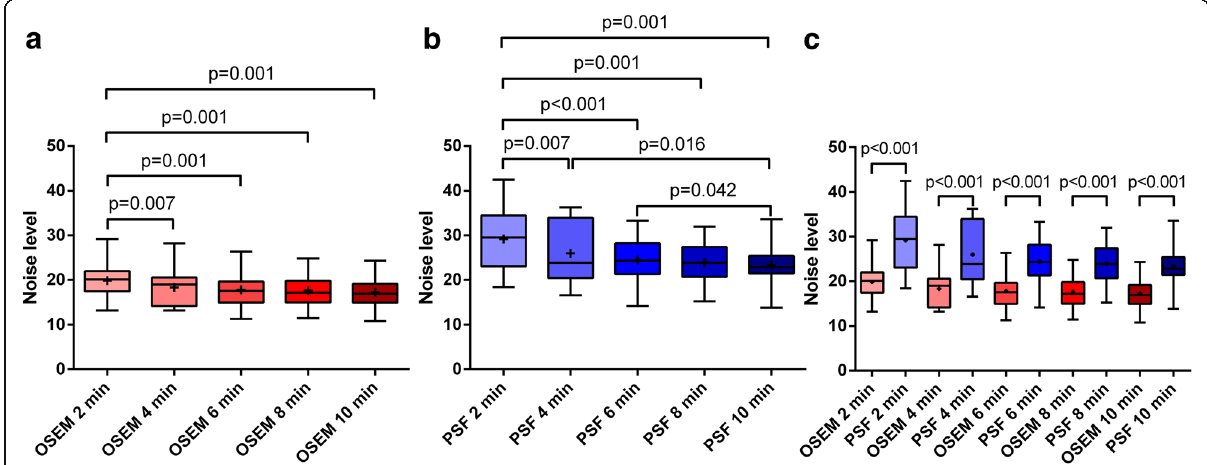
Fig. 1 Noise level measured in the vascular background in 3D-OSEM-reconstructed ( a ) and PSF allpass -reconstructed ( b ) head-and-neck PET data sets for each of the five acquisition times per bed position from 2 to 10 min with a 2-min increment. c Comparison of the noise level between 3D-OSEM and PSF allpass -reconstructed head-and-neck PET data